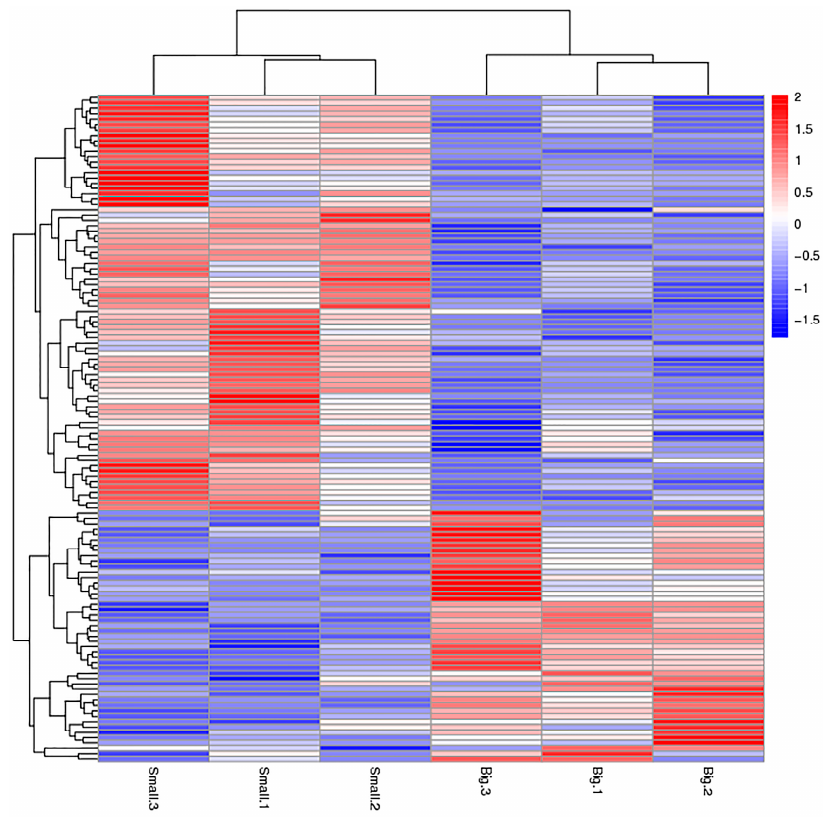
Figure 1. Hierarchical clustering analysis of the two size classes of abalone analyzed, showing the proteins differentially expressed between small and large specimens of Haliotis discus hannai . Red and blue colored bars indicate up- and down-regulation, respectively.